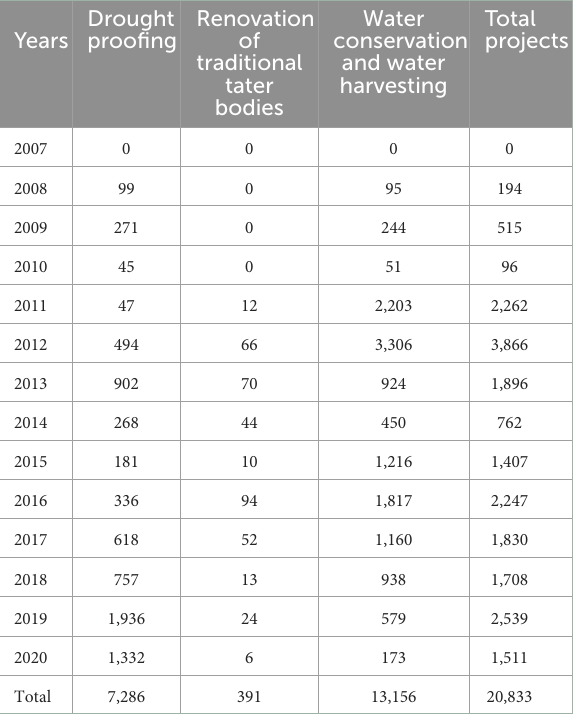
TABLE 4 MGNREGS-IWMP projects completed in Ahmednagar district from 2007 to